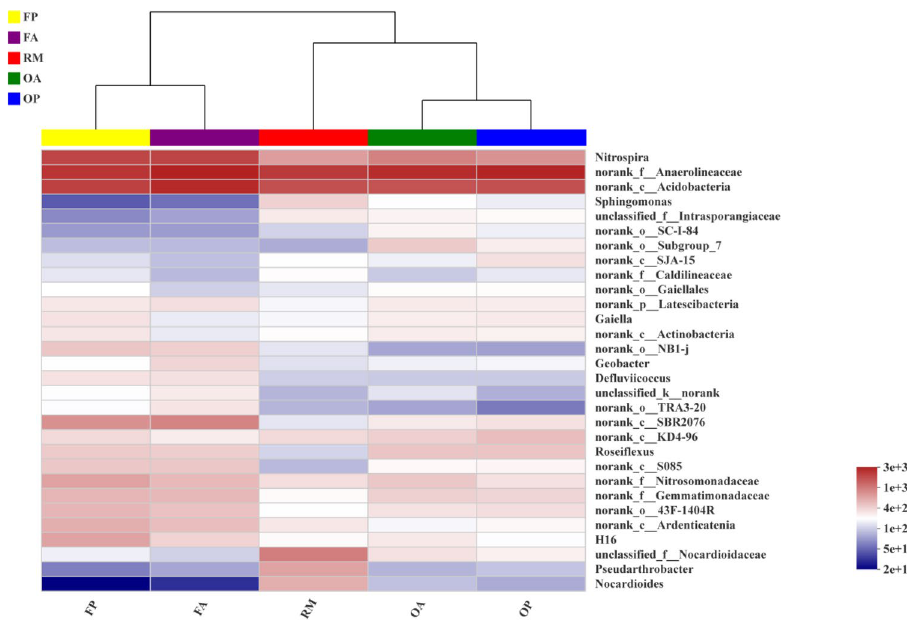
Figure 5. Heatmap of cluster analysis of the top 30 genera in different rice systems and